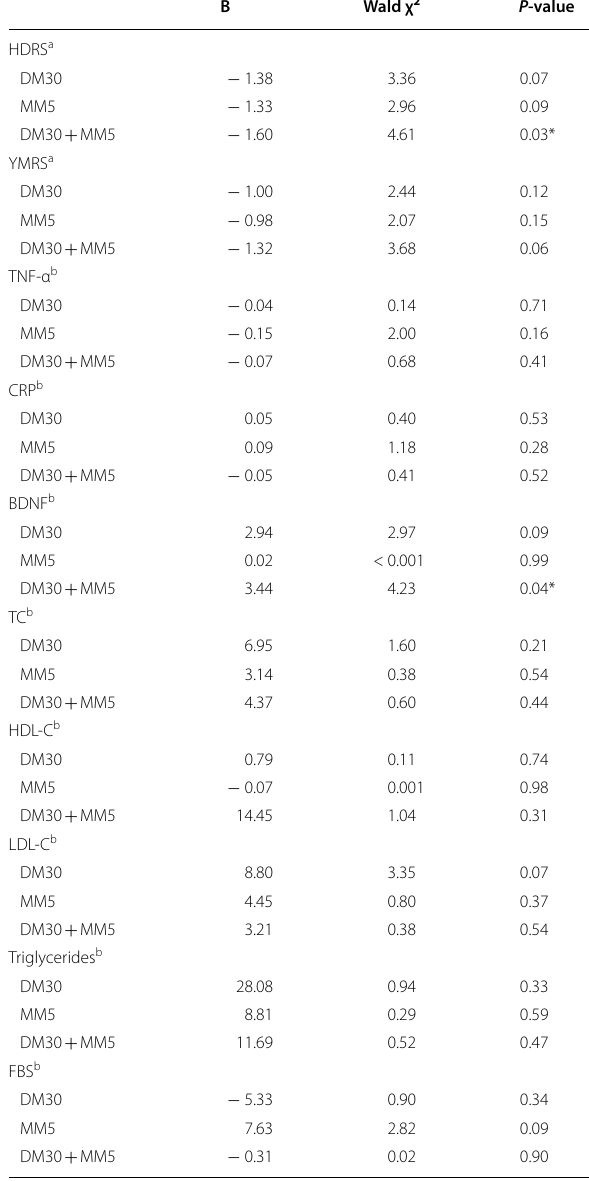
Table 3 Difference in outcomes of add-on medication (DM30, MM5, and DM30 MM5) versus Placebo in BD-II +